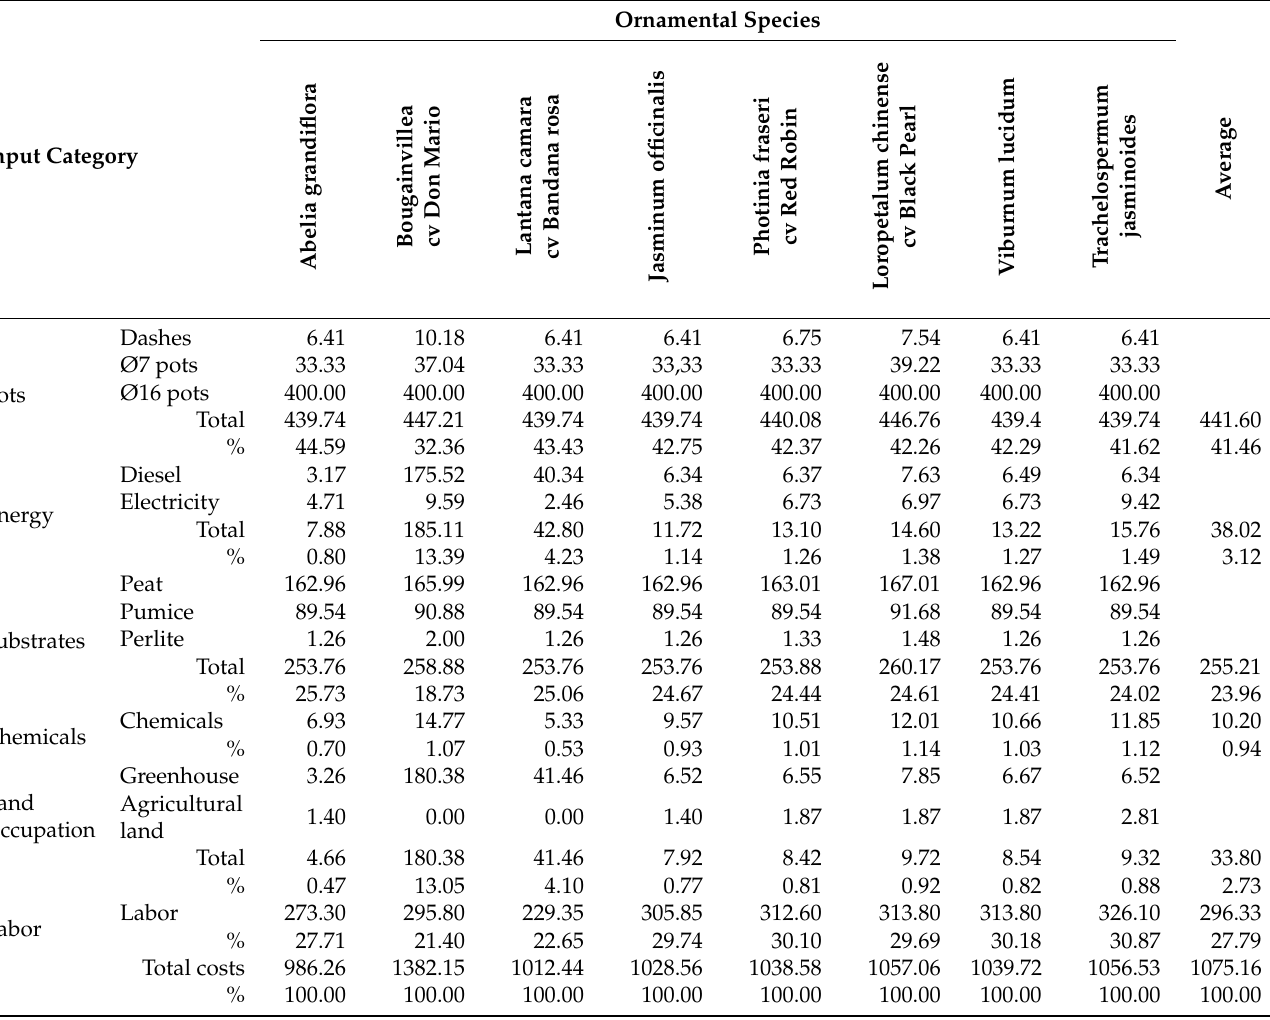
Table A4. Input categories’ costs associated with NSM ornamental production model of 1000 plants (based on market prices. Year: 2021).